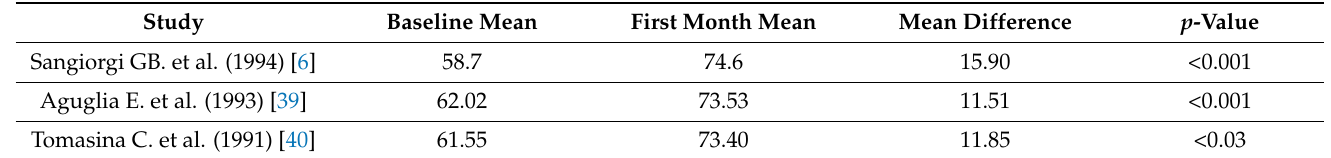
Table 2. Comparison of the Mathew’s scale scores at baseline and after the first month of treatment with choline alphoscerate for patients with stroke.